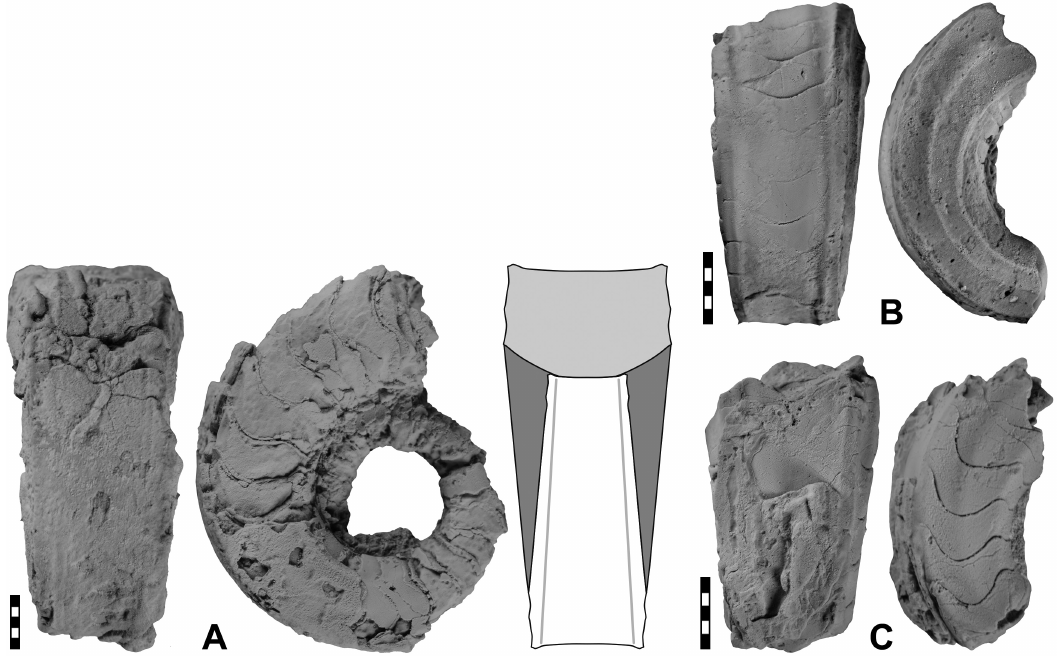
Fig. 11. Stroboceras ancilis sp. nov. from Timimoun (all Korn et al . 2002 Coll.). A . Paratype MB.C.30459.3. B . Paratype MB.C.30459.2. C . Holotype MB.C.30459.1. Scale bar units = 1 mm.